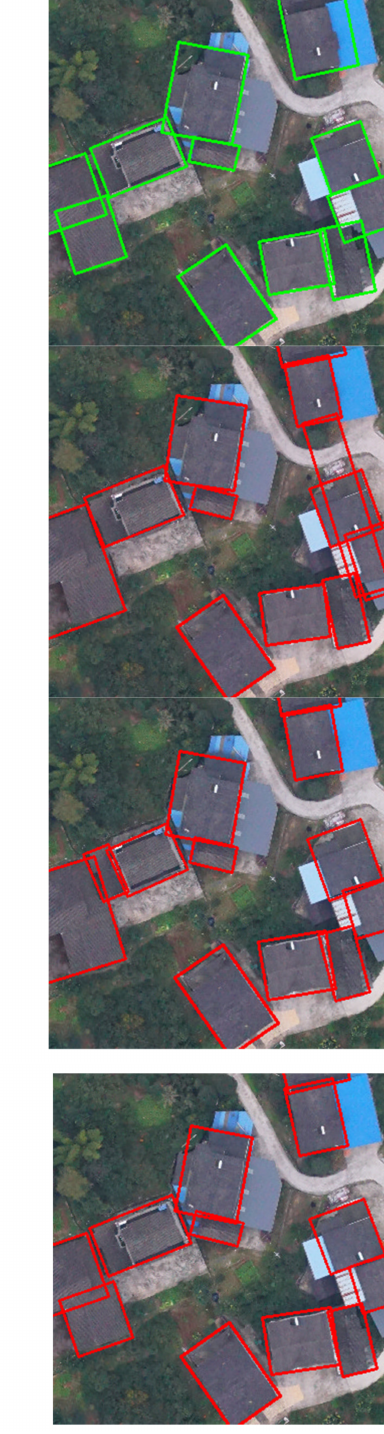
Figure 11. Comparison of detection of R3Det, SCRDet, and TRDet: TRDet has better performance in detecting dense buildings. ( a ) Represents the ground truth; ( b ) represents the R3Det detection results; ( c ) denotes SCRDet detection results; ( d ) denotes TRDet detection